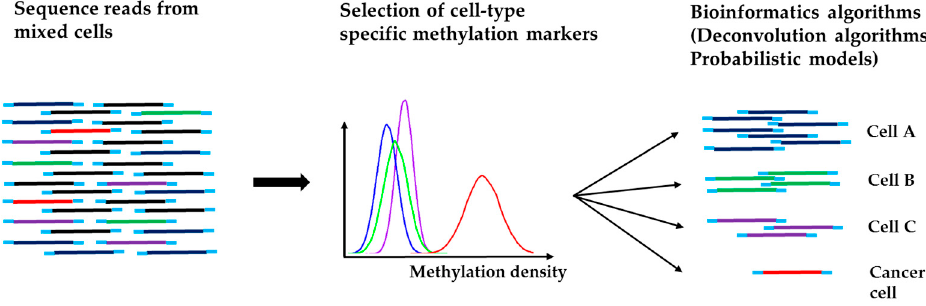
Figure 4. Schematic approach to map cancer tissue of origin from WGS methylation analysis.